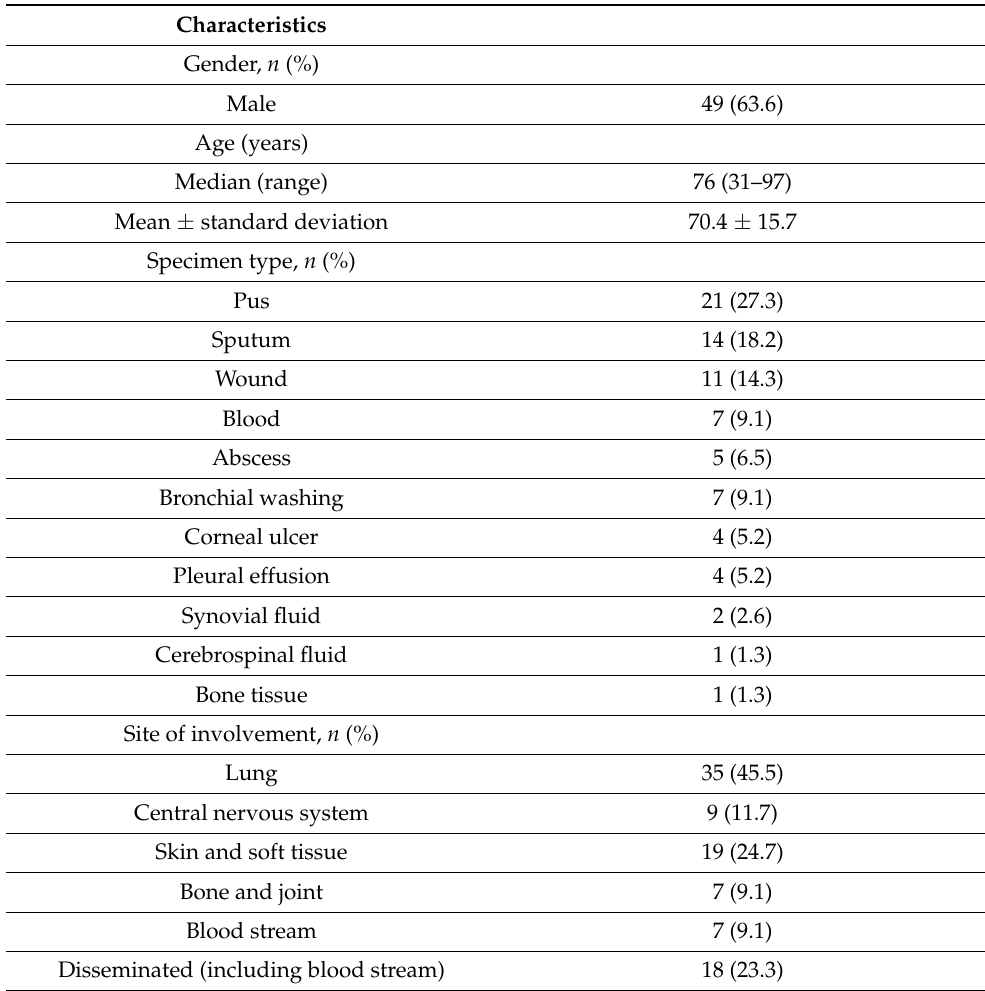
Table 1. The clinical characteristics of the 77 included